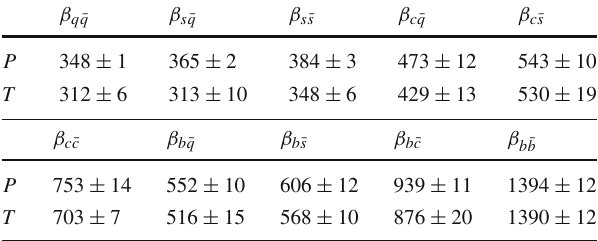
Table 9 The values of Gaussian parameters β (in units of